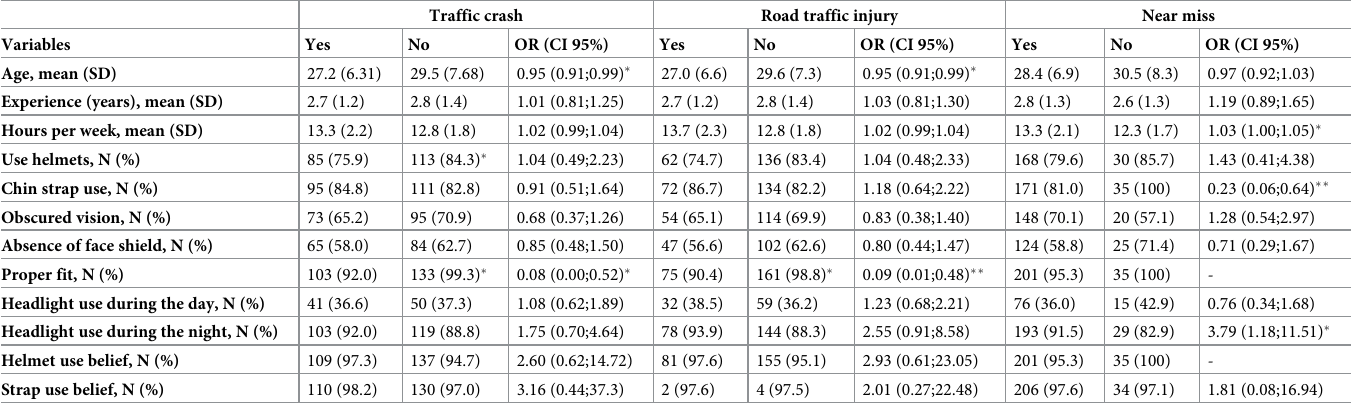
Table 2. Association between boda boda safety habits and road traffic